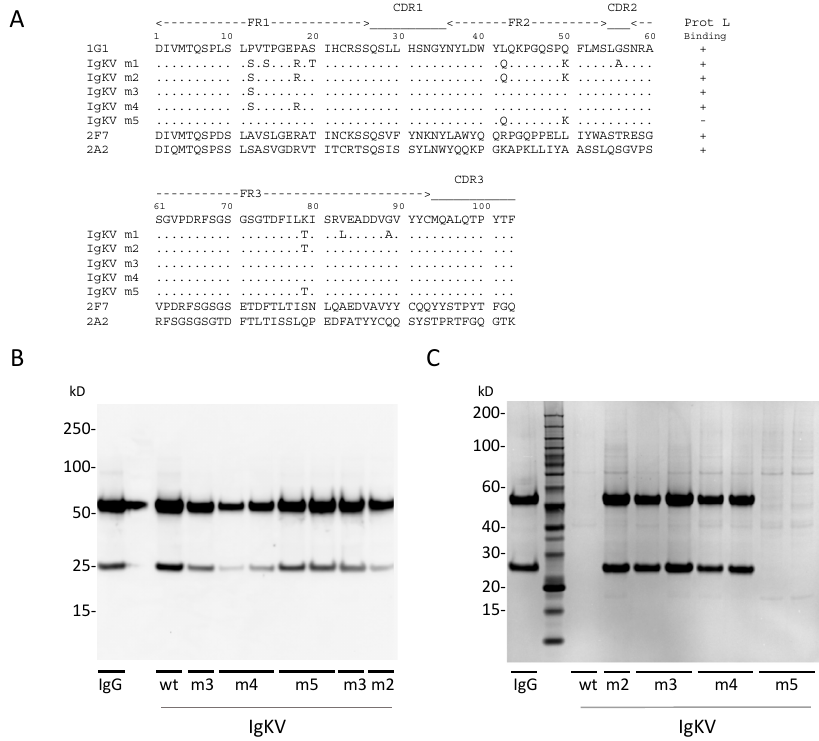
Figure 5. Assessment of human κ light chain variants for binding to Protein L. ( A ) The amino acid sequence of the 1G1 κ light chain (V κ II subtype) is shown, as well as the amino acid mutations tested. The framework regions (FR1, FR1, FR3) and complementarity determining regions (CDR1, CDR2, CDR3) are shown above. Also shown are the sequences of 2F7 (V κ IV subtype) and 2A2, the V κ I light chain used for the reference crystal structure [43]. ( B ) Western blot of IgGs expressed in supernatants of cells co-transfected with κ LC wt or mutant genes as shown in ( A ) or the 1G1 IgG heavy-chain gene. Double lanes for some mutants represent independent transfections. ( C ) Supernatants shown in ( B ) were run through Protein L columns and retained IgGs were analyzed by SDS-PAGE. IgG, purified 1G1 IgG, expressed with P12S κ mutation.